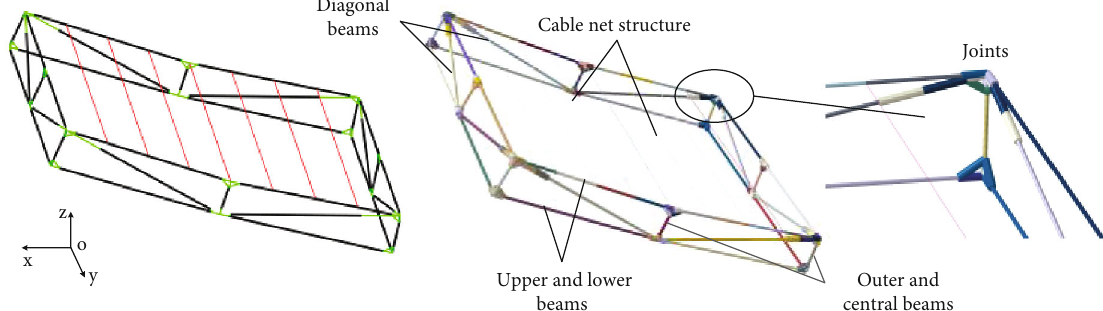
Figure 1: Basic unit structure of modular space